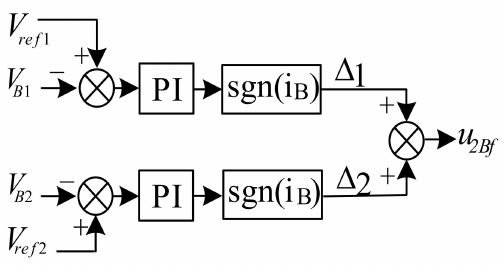
Figure 9. Control strategy of cell capacitance voltage.